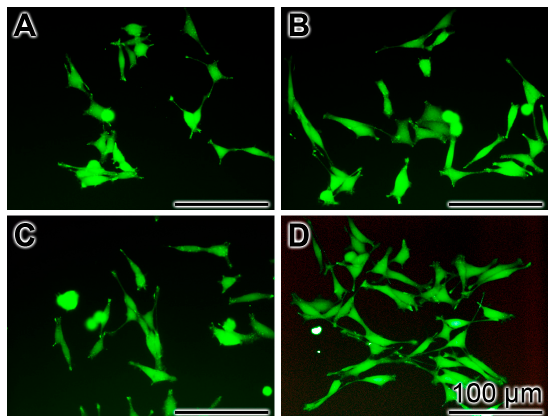
Figure 6. Frequency of cells in a microscopic view-frame pre-treated with phosphate/polyP (24 h) and treated with A β 25-35 (6 h). The PC12 cell cultures remained untreated ( A ) or were pre-treated with 30 µ g/mL of Na-polyP[Ca 2+ ] ( B ); Ca-phosphate-NP ( C ); or Ca-polyP-MP ( D ). After staining with Calcein AM the cells were inspected by fluorescence microscopy.